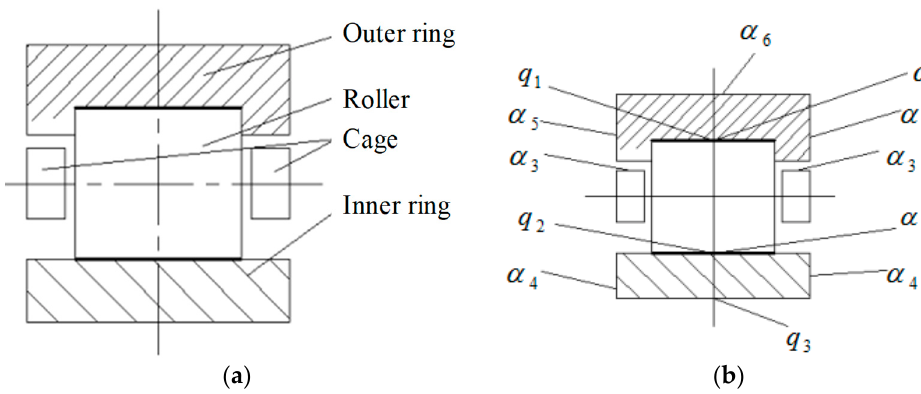
Figure 8. Temperature distribution analysis model. ( a ) Solid model; ( b ) boundary condition model.